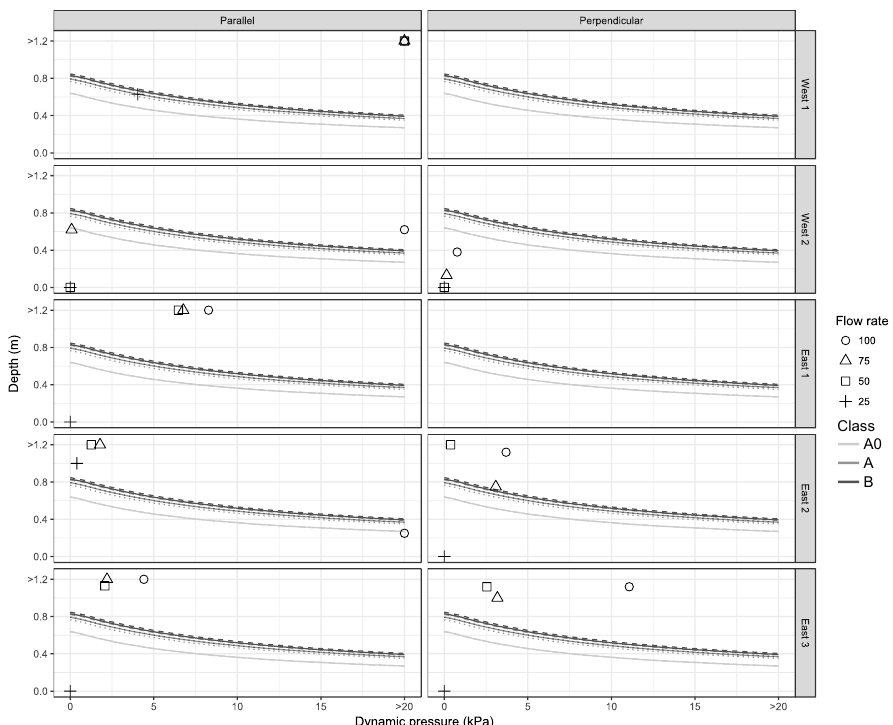
Figure 11. Critical depth–pressure curves for building classes A0, A and B subjected to a debris flow. Peak normal pressures and correspond- ing depths applied to each city block are plotted as points for each flow